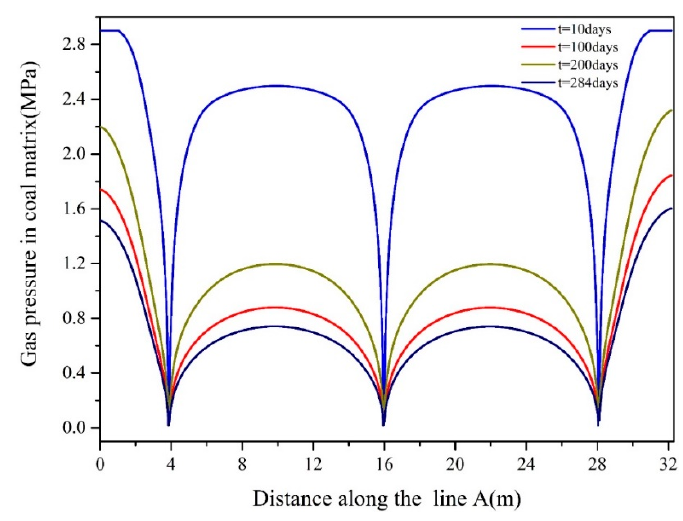
Figure 7. Gas pressure evolutions in the matrix along line A.